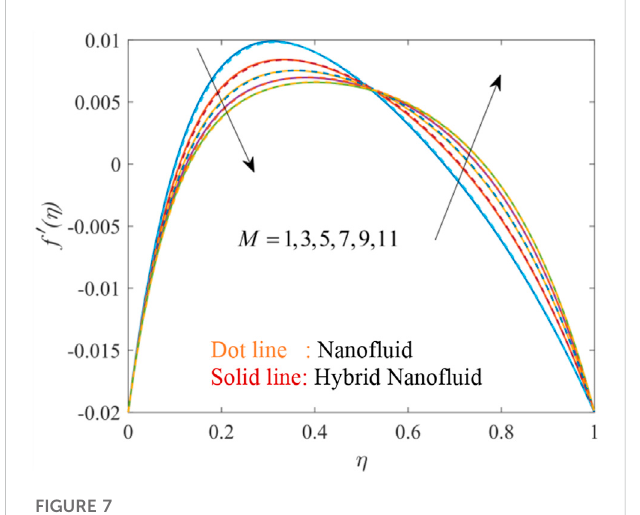
FIGURE 9 Effect of nanoparticles volume fraction φ on f ( η ) .